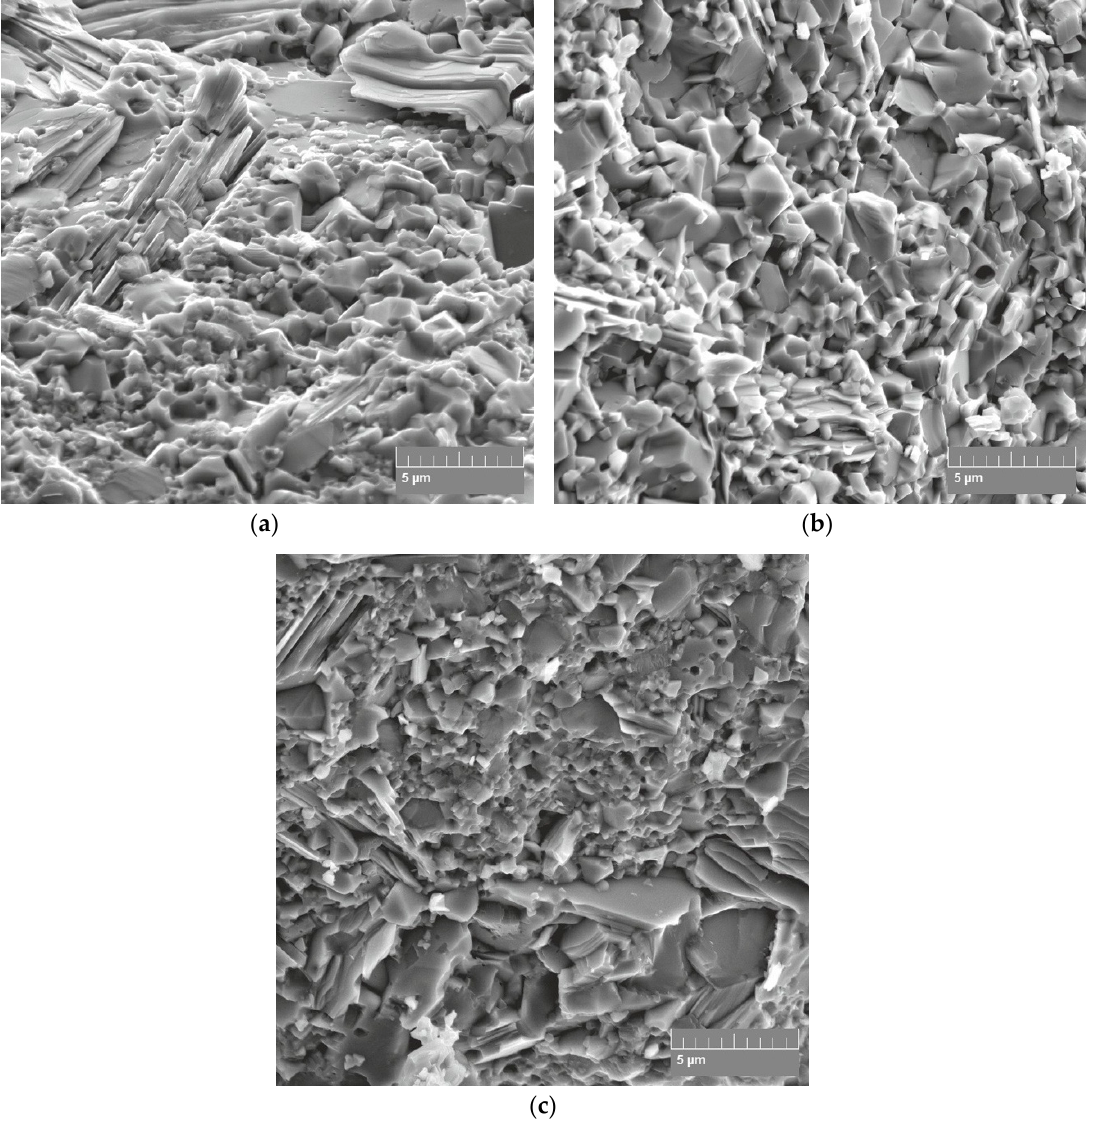
Figure 8. SEM micrographs of fracture surface topography of composites SPSed at: 1350 °C ( a ); 1400 °C ( b ) and 1450 °C ( c ).